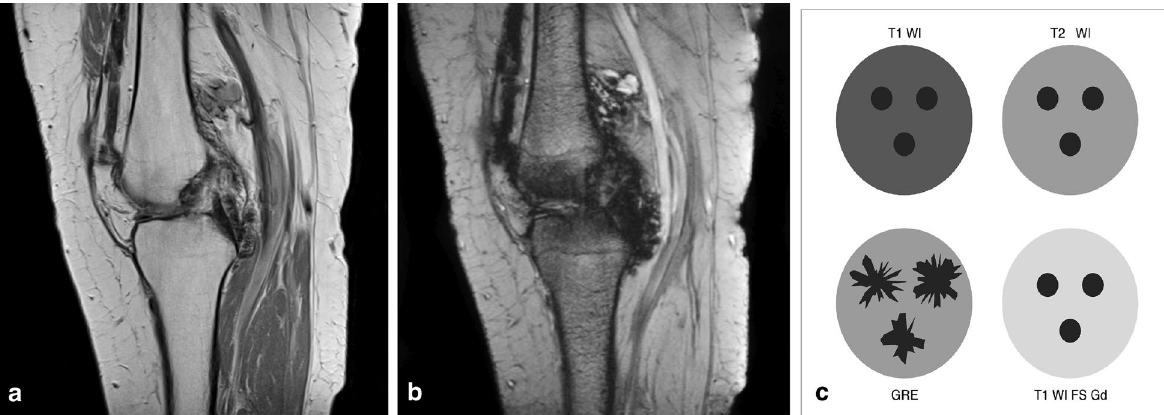
Fig. 3 Blooming artefact. a Sagittal PD-weighted MR image of the knee in a patient with D-TGCT demonstrates multiple low signal intensity synovial lesions posterior to the PCL, along the posterior cortex of the femoral metaphysis and in the collapsed suprapatellar recess. b Sagittal T2- gradient echo weighted MR image of the knee showing blooming artefact: the low signal intensity synovial lesions containing hemosiderin increase in size and are ill defined, appearing as cloud-like dark areas. c Schematic illustration of hemosiderin signal intensities on gradient echo (GRE) weighted sequences versus T1- and T2-weighted sequences. Gradient echo images show increased size of the hemosiderin foci with irregular margins, this is called